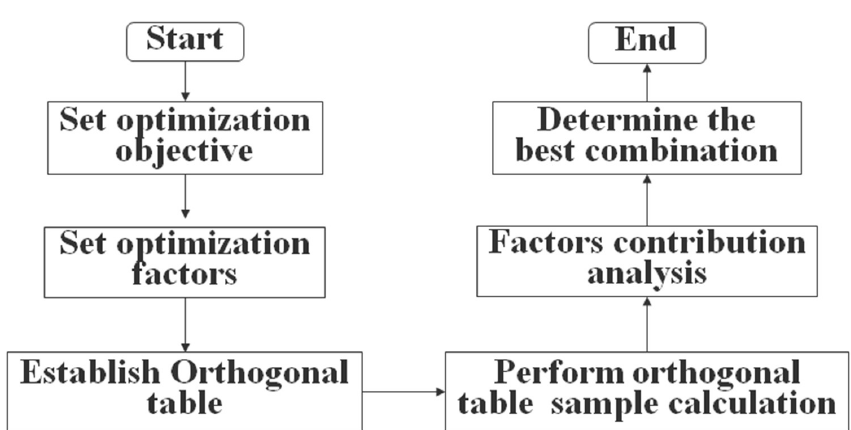
Figure 6. MOGA optimization process.